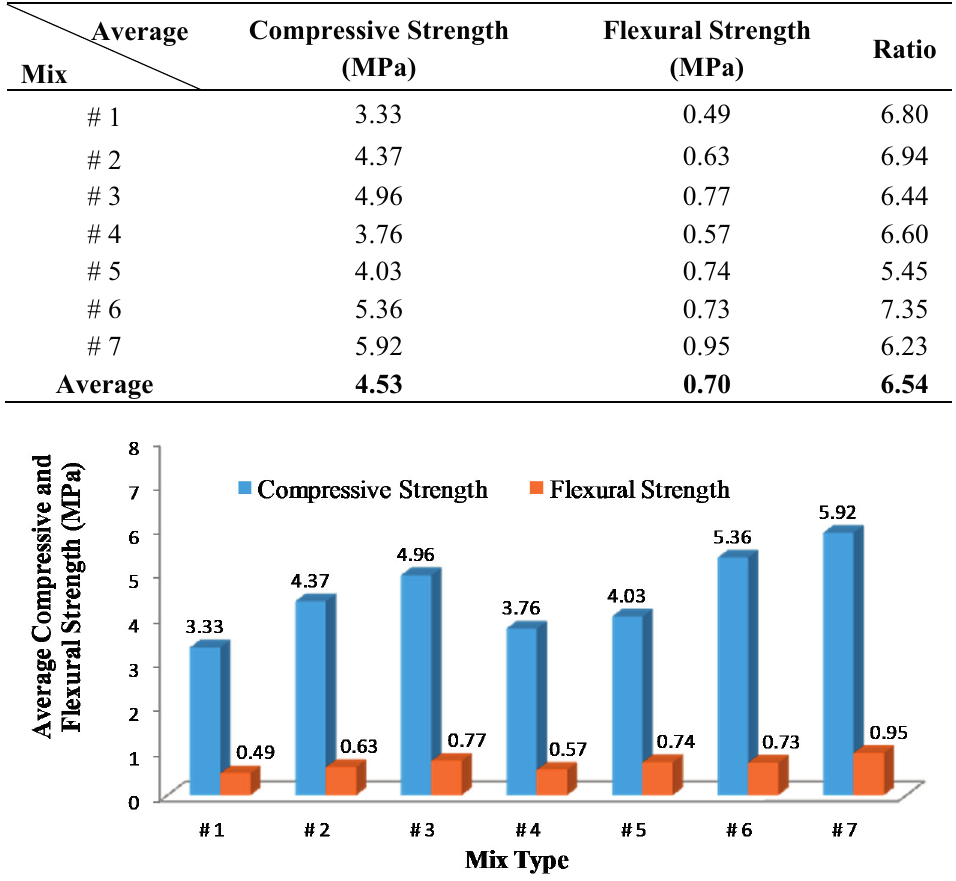
Table 8. Ratio and average values of compressive and flexural strength.